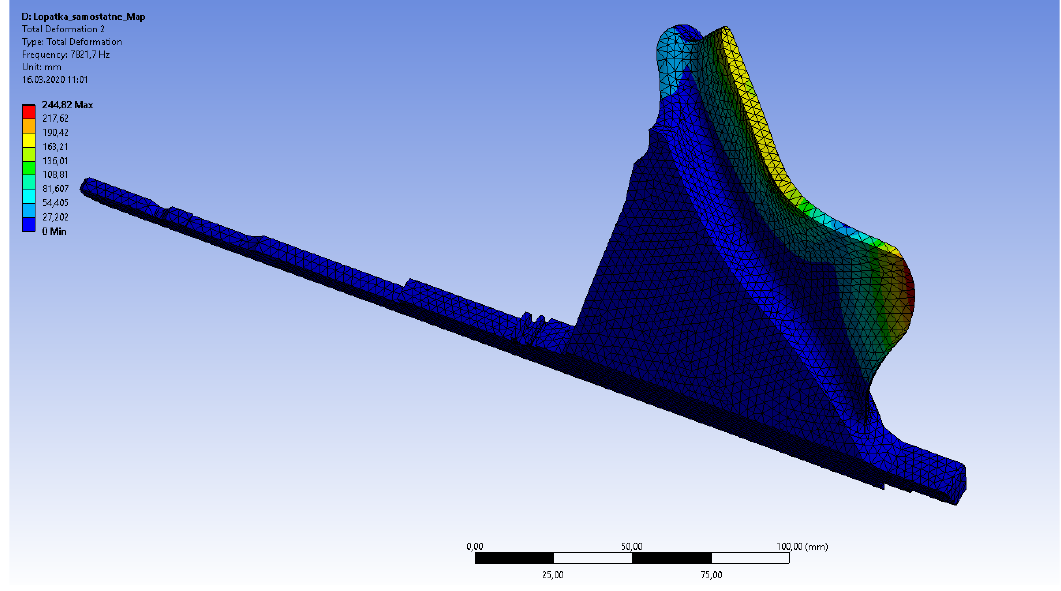
Figure 7. Example of a mode shape of a turbocharger turbine blade segment (mode 2).